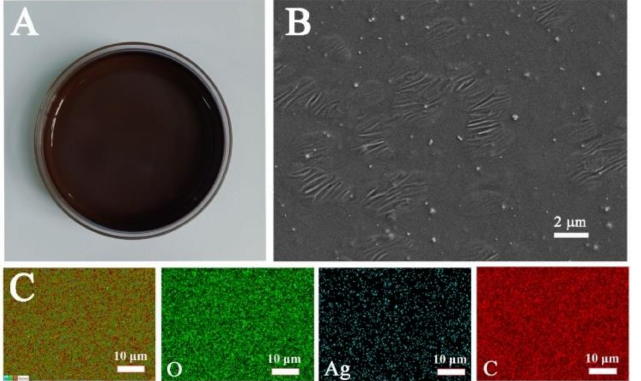
Figure 1. MC decorated with Ag NPs before drying ( A ), SEM image of the MC/Ag NPs SERS film substrate ( B ), and SEM-EDX images of the MC/Ag NPs film substrate ( C ). The XRD patterns of methylcellulose and methylcellulose decorated with